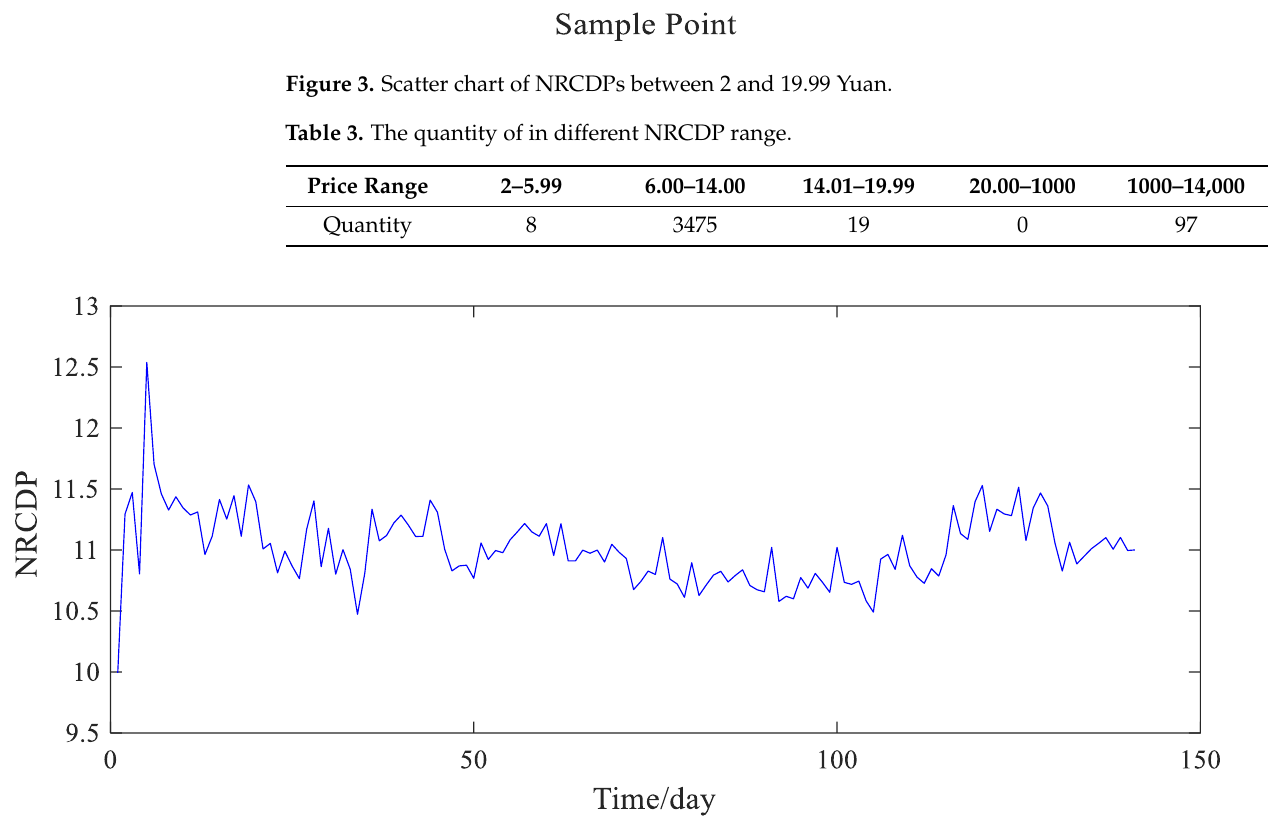
Figure 3. Scatter chart of NRCDPs between 2 and 19.99 Yuan. Table 3. The quantity of in different NRCDP range.